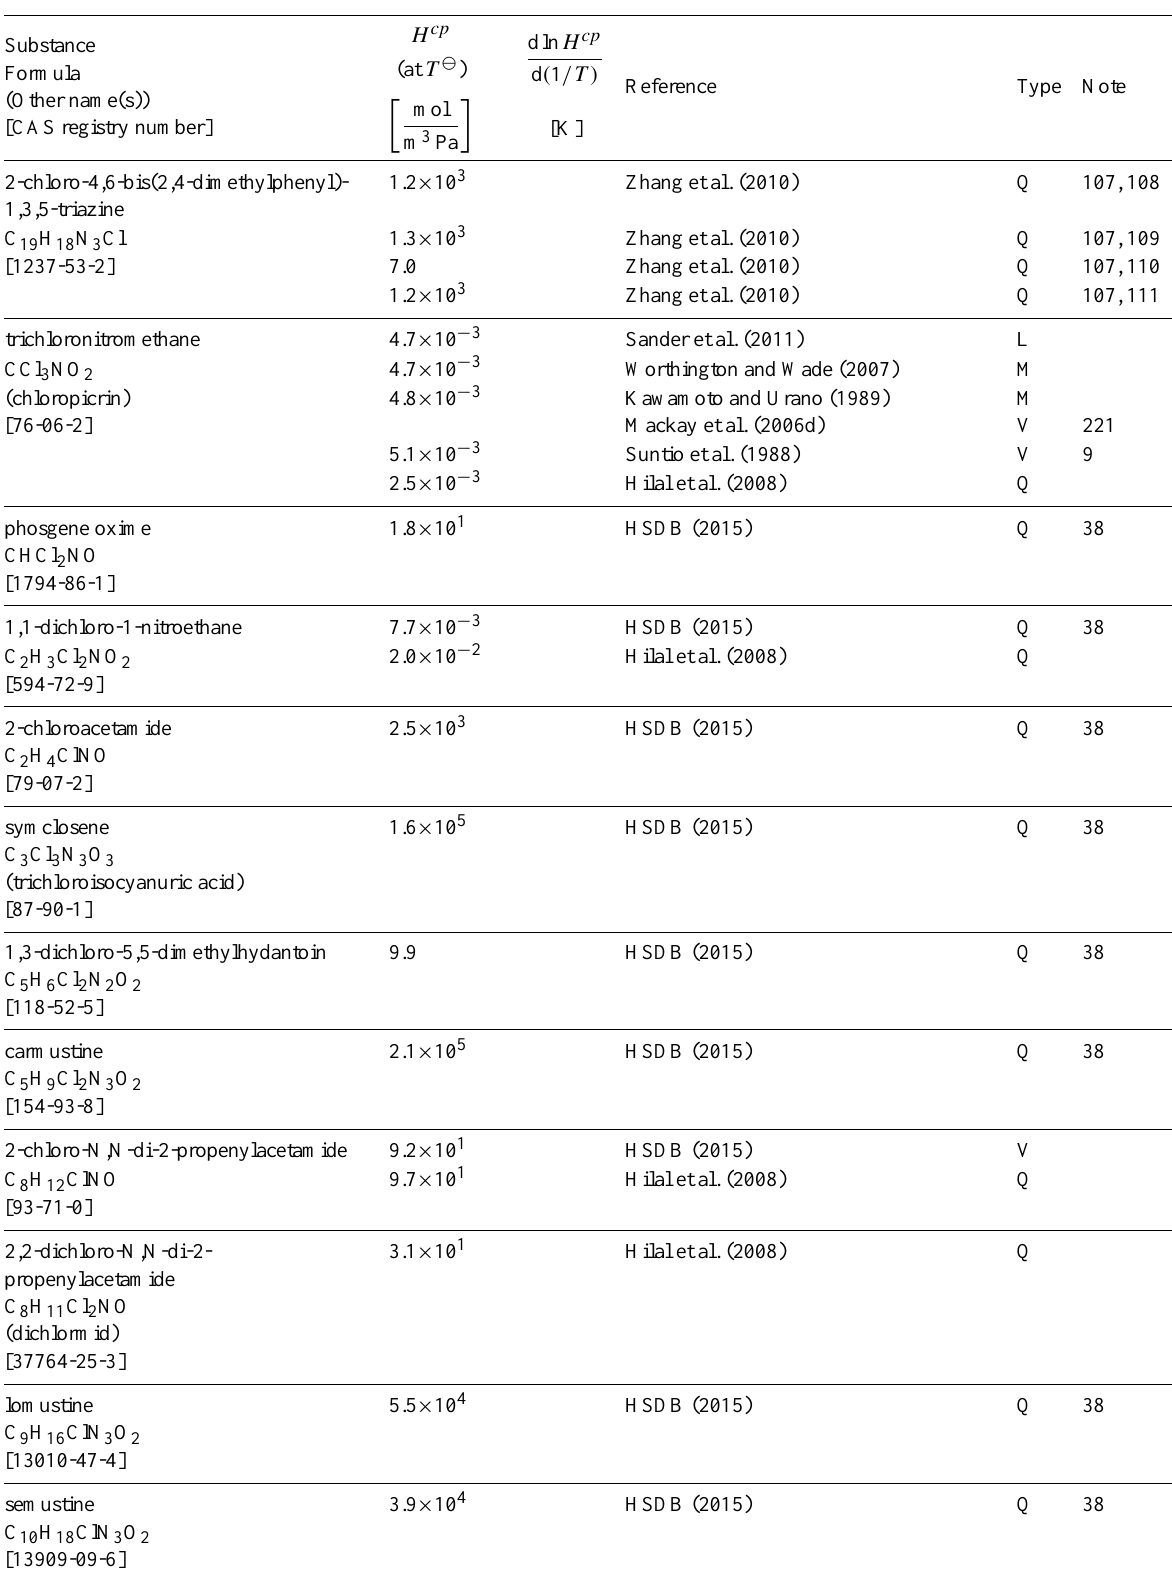
Table 6: Henry’s law constants for water as solvent